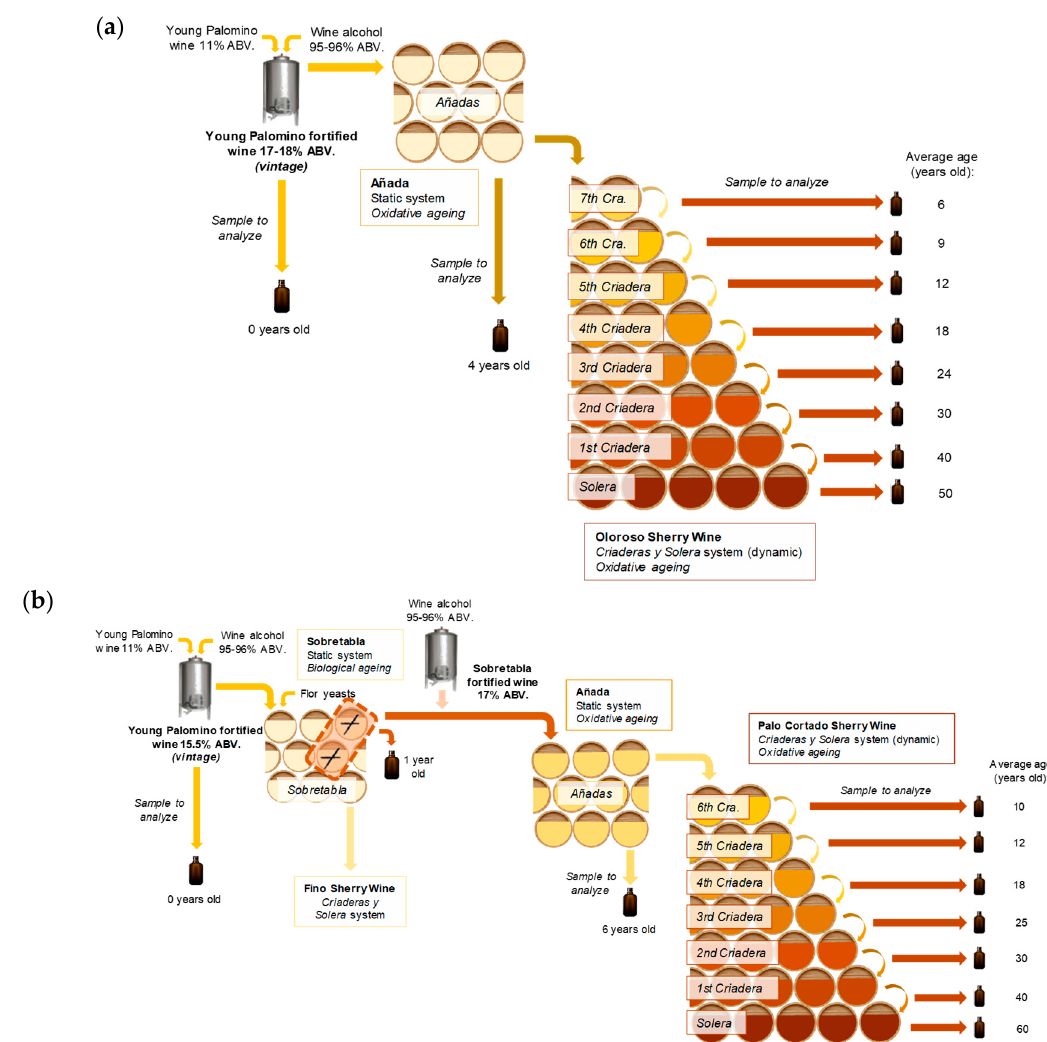
Figure 1. Ageing and sampling diagram of the sherry wines: ( a ) Oloroso Sherry; ( b ) Palo Cortado Sherry.